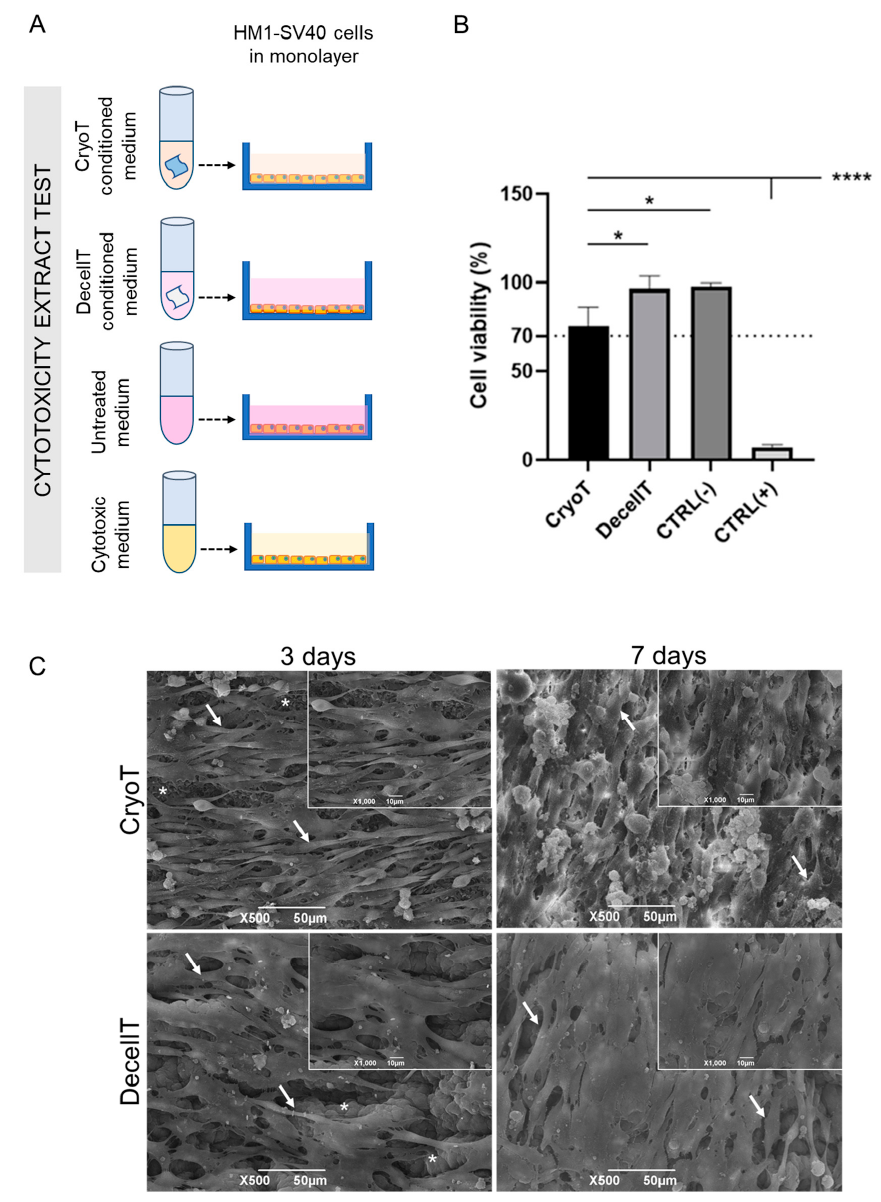
Figure 12. Cytocompatibility evaluation through the indirect and the direct methods. ( A ) Schematic figure showing the methodological approach to perform the cytotoxicity extract test. ( B ) test results on HM1-SV40 cell line. The cells were incubated for 24 h with culture media previously conditioned with cryopreserved and decellularized trachea (CryoT and DecellT, respectively). For each group, cell viability percentage was determined by comparison with that of untreated cell cultures, set at 100% of viability (*: p < 0.05; ****: p < 0.0001). ( C ) SEM analysis of cell-scaffold interactions in terms of cell attachment, morphology and proliferation on tracheal matrices. Scale bar: 50 µm; 10 µm (top right insert).